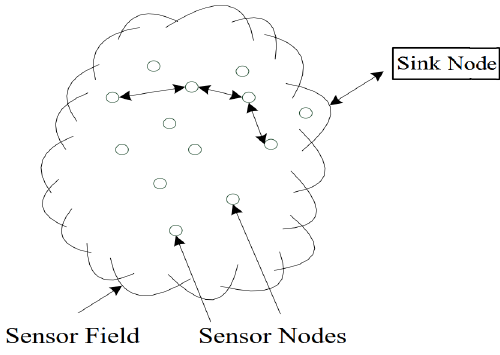
Figure 1. The topology diagram of wireless sensor networks.